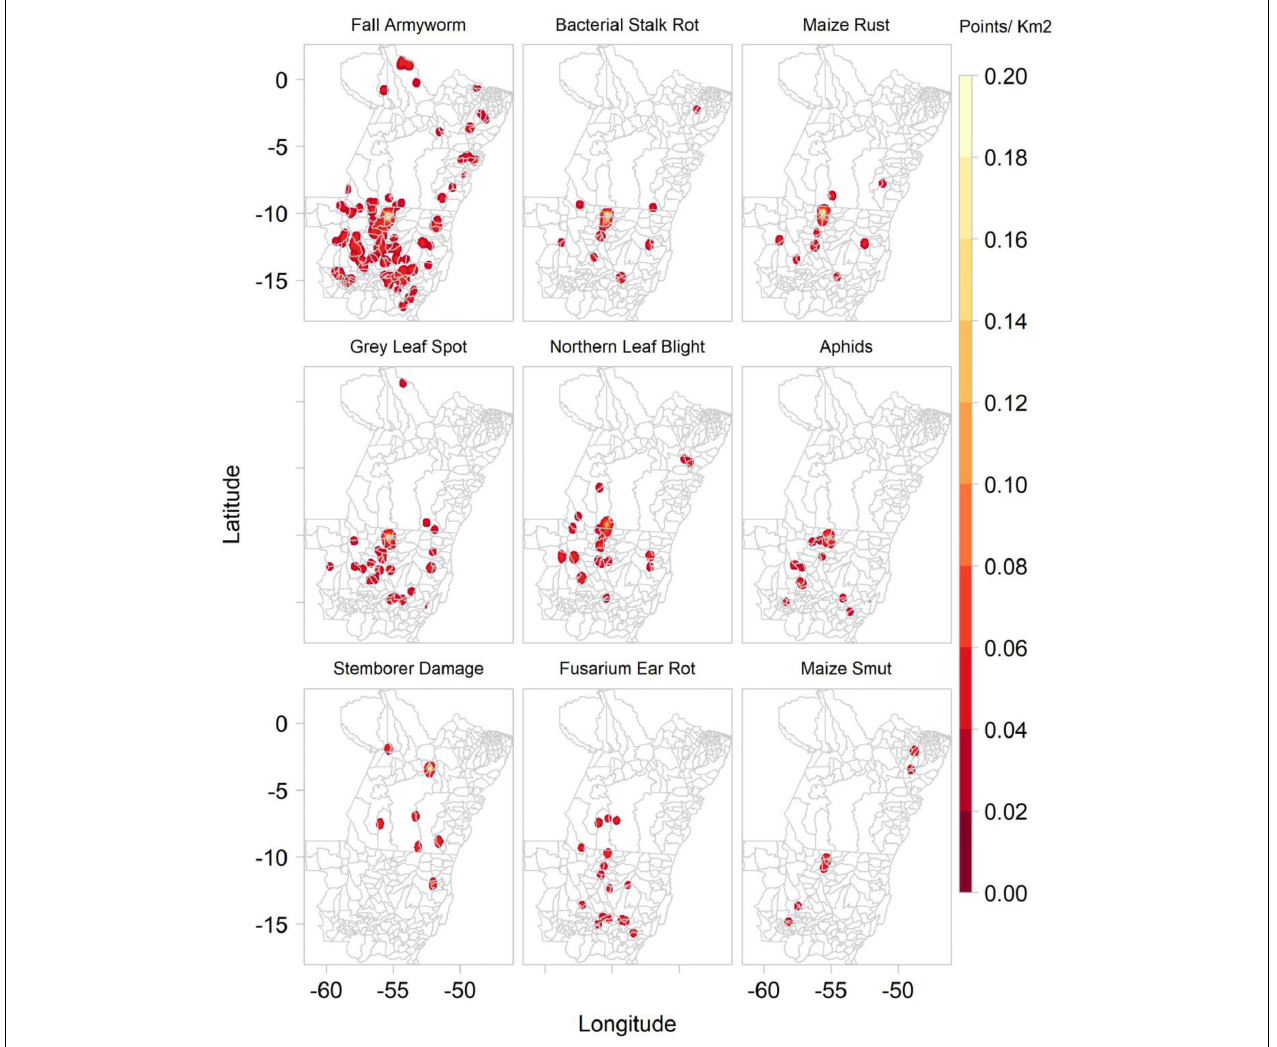
FIGURE 7 | Kernel density of the main maize pathogens and animal pests based on ConvNet predictions provided for images collected by Plantix users in Mato Grosso and Pará, Brazil, between November 2016 and May